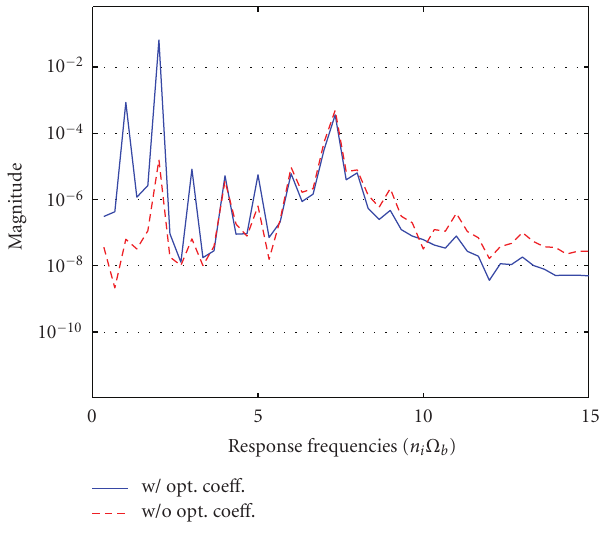
Figure 18: Horiz. response mag. profiles at Ω b = 0 . 6, bearing